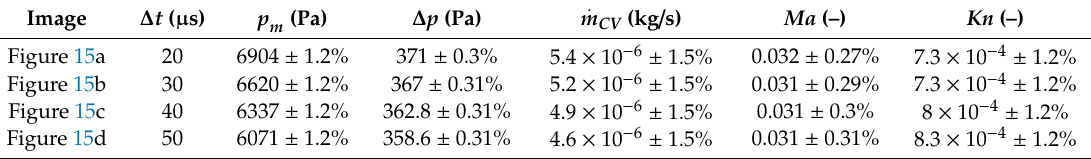
Table 2. Flow properties associated to the images of Figure 15. The reported percentage change indicates how much the properties vary inside the group of N i = 20 average